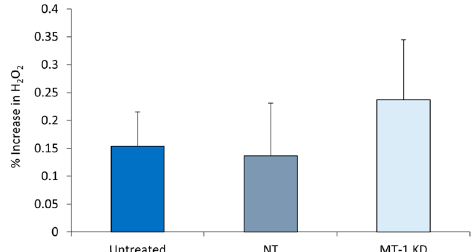
Figure 5. H 2 O 2 generation is elevated in MT-1 knockdown NHDF exposed to UV. NHDF were treated with non-targeted siRNA (NT), targeted siRNA (MT-1 KD) or untreated, and exposed to UV (5 J / cm 2 of UVA + 50 mJ / cm 2 of UVB). The amount of H 2 O 2 generated were quantitated as described in Methods and normalized to the total cellular protein. Error bars are SEM. N = 4.